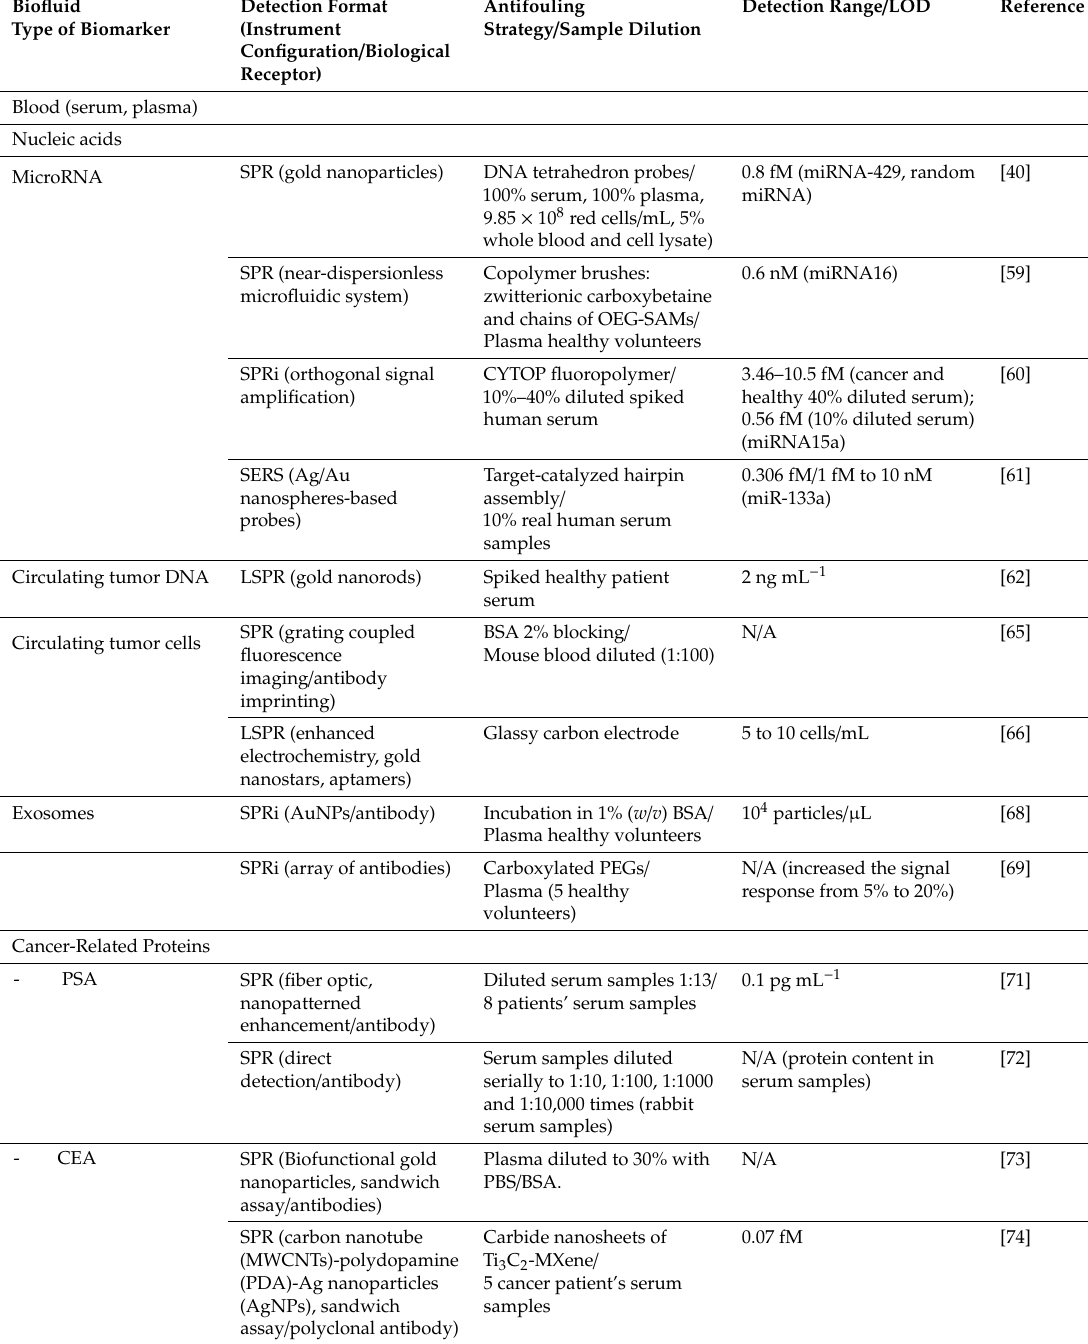
Table 1. Key analytical features of clinical diagnostics by plasmonic biosensors classified according to the characteristics of biological samples, detection format (namely instrument configuration or biological receptor) and sensitivity or detection